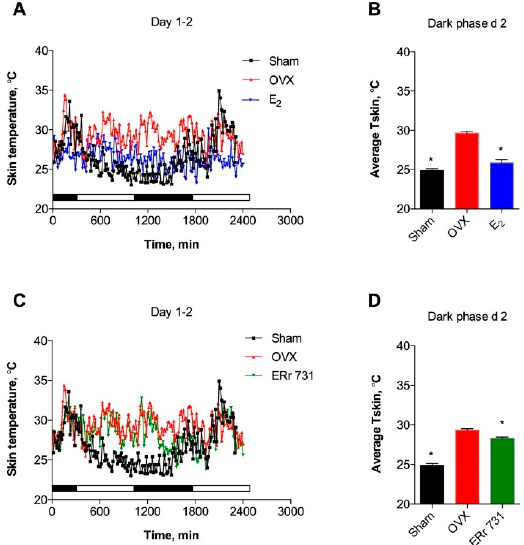
Figure 2. Effects of ERr 731 and 17 β -estradiol (E 2 ) on tail skin temperature (T skin ) in ovariectomized (OVX) rat model after 2 days of treatment. ( A ) Recordings of OVX controls (red) show circadian rhythm and increased T skin as compared to intact (Sham, black) animals, while E 2 treatment (blue) is associated with decreased T skin on days 1–2; ( B ) Average T skin is significantly increased in OVX rats and is reduced following E 2 treatment in the dark phase of day 2; ( C ) Recordings of decreased T skin following ERr 731 treatment (green) on days 1–2; ( D ) Average T skin is significantly reduced in ERr 731-treated rats in the dark phase of day 2. Data are the mean ± SEM ( n = 6), * p < 0.05 vs. OVX control.